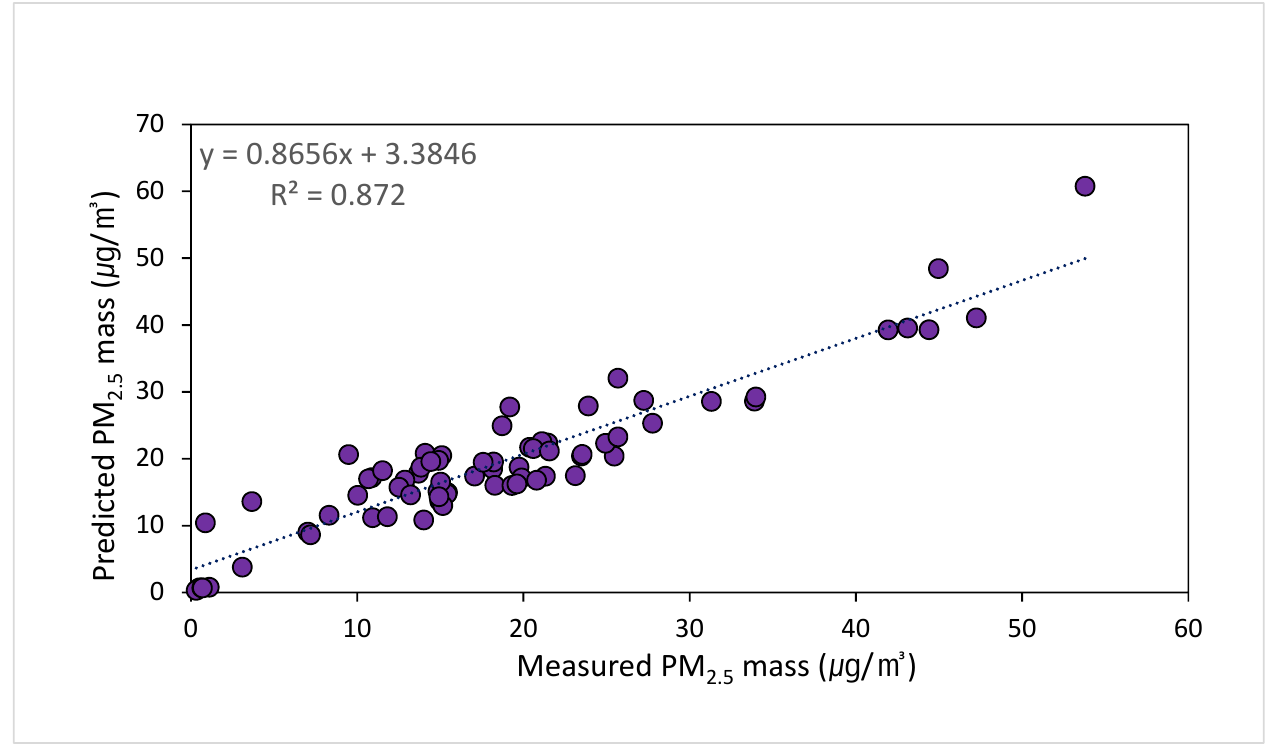
Figure 7. Mass concentrations of PM 2.5 predicted from PMF modeling versus measured mass concentrations.